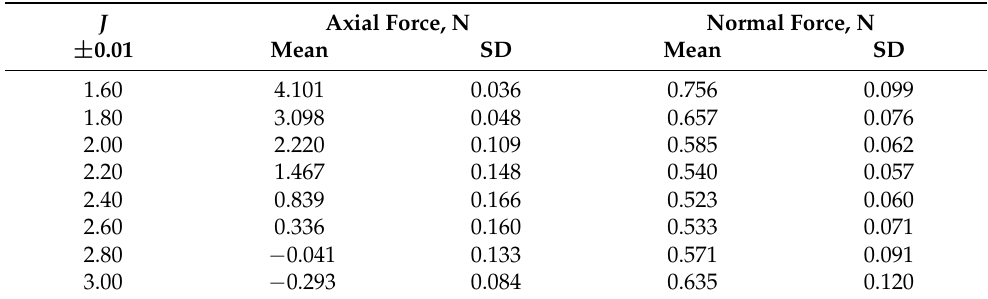
Table 4. Uncertainty in measurements of standalone propeller forces. Test conditions: V ∞ = 35m/s, α = 4°, β = 0°.